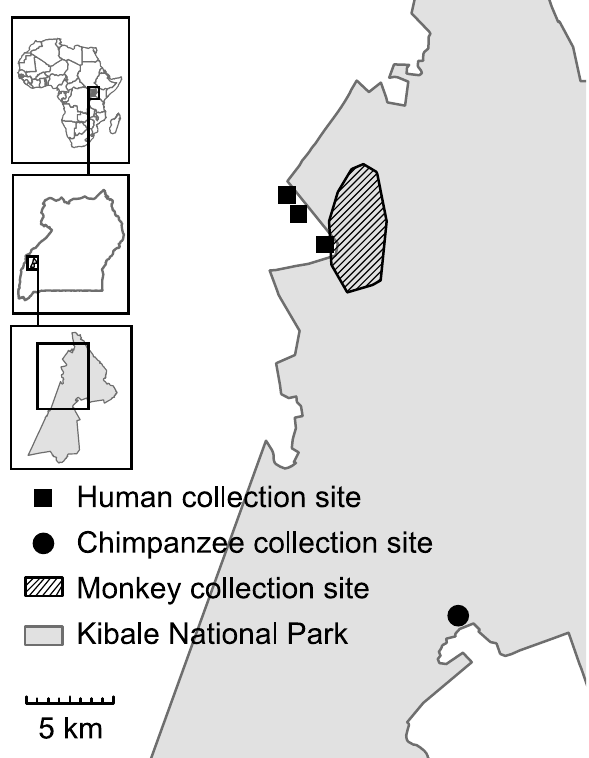
Figure 1. Map of sample collection sites in and around Kibale National Park,